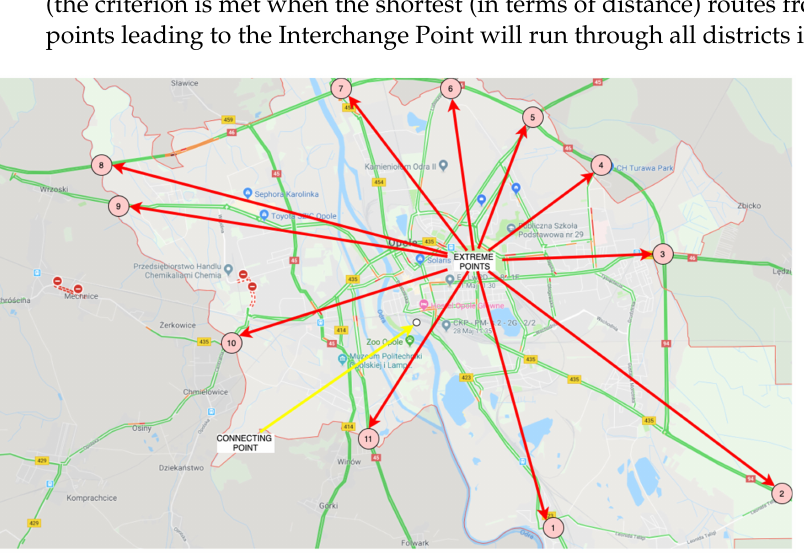
Figure 4. Stage 2—Creation of a radial city layout.